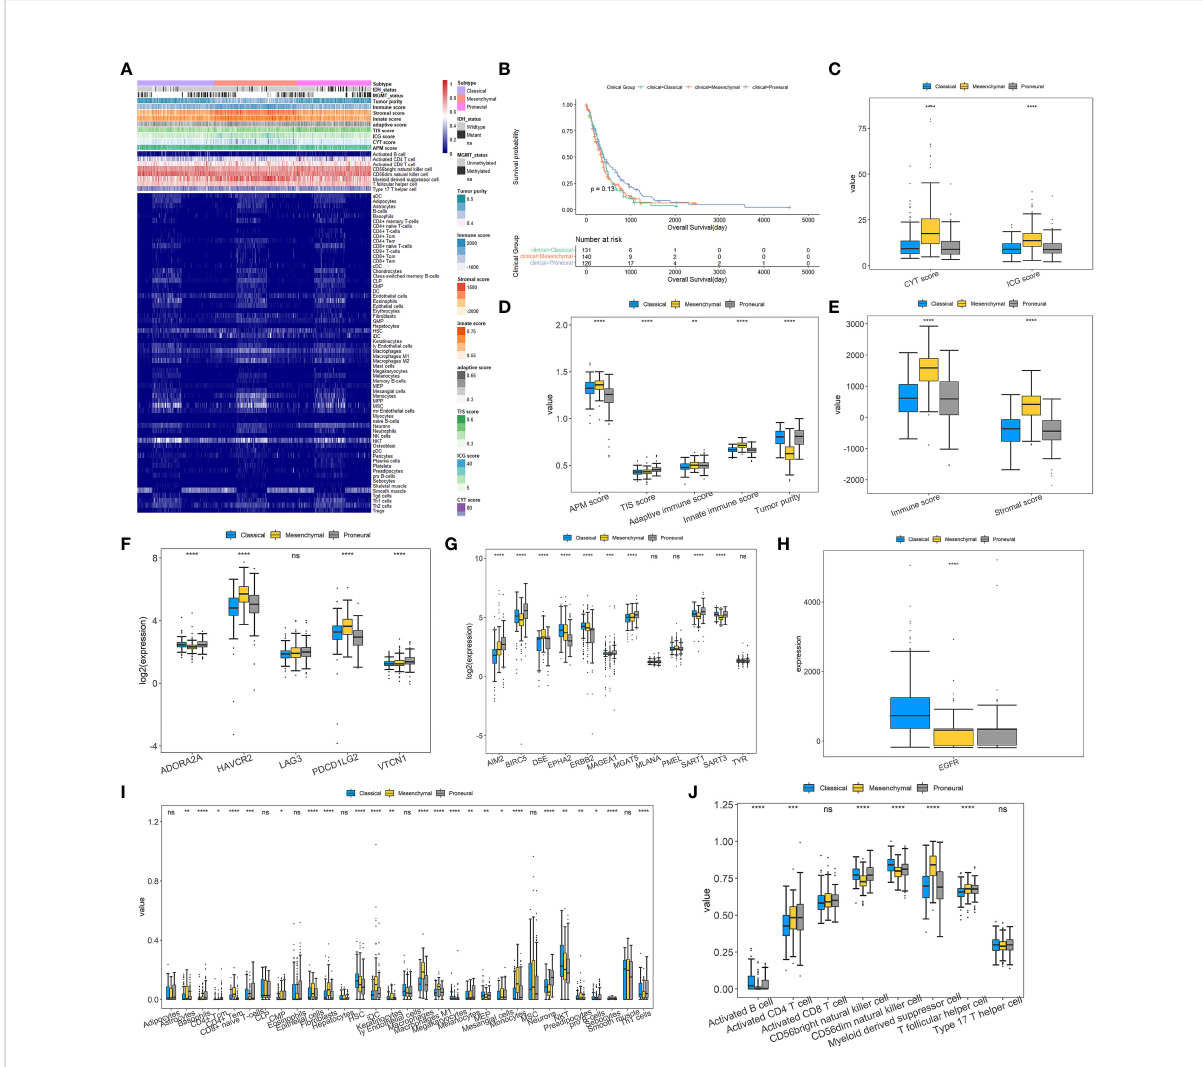
FIGURE 3 Landscapes of tumor immune microenvironment and clinicopathological characteristics of three GBM subtypes. (A) Heatmap depicting the association between GBM subtypes and immune cell in fi ltration. (B) The Kaplan – Meier curve for the OS of 397 GBM patients in three GBM subgroups. (C – E) Box plots for exploring the differences of CYT, ICG, APM, TIS, adaptive immune, innate immune, immune and stromal scores, and tumor purity among GBM subtypes. (F) Differences in the expressions of T-cell exhaustion markers between the three GBM subtypes. (G, H) Differences in the expressions of glioma antigens across the three GBM subtypes. (I, J) Different proportions of various immune and stromal cells in the GBM subgroups. For all box plots, the Kruskal – Wallis test was used to determine the signi fi cance of differences among GBM subtypes, and p -values are shown on the top of each box plot. * p < 0.05; ** p < 0.01; *** p < 0.001; **** p < 0.0001; ns, no signi fi cant